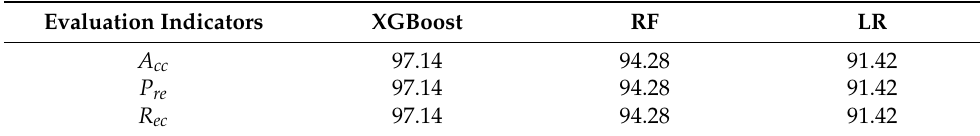
Figure 7. Confusion matrix of the marine accident classification and prediction model. Table 3. Comparison of model prediction accuracy (%).